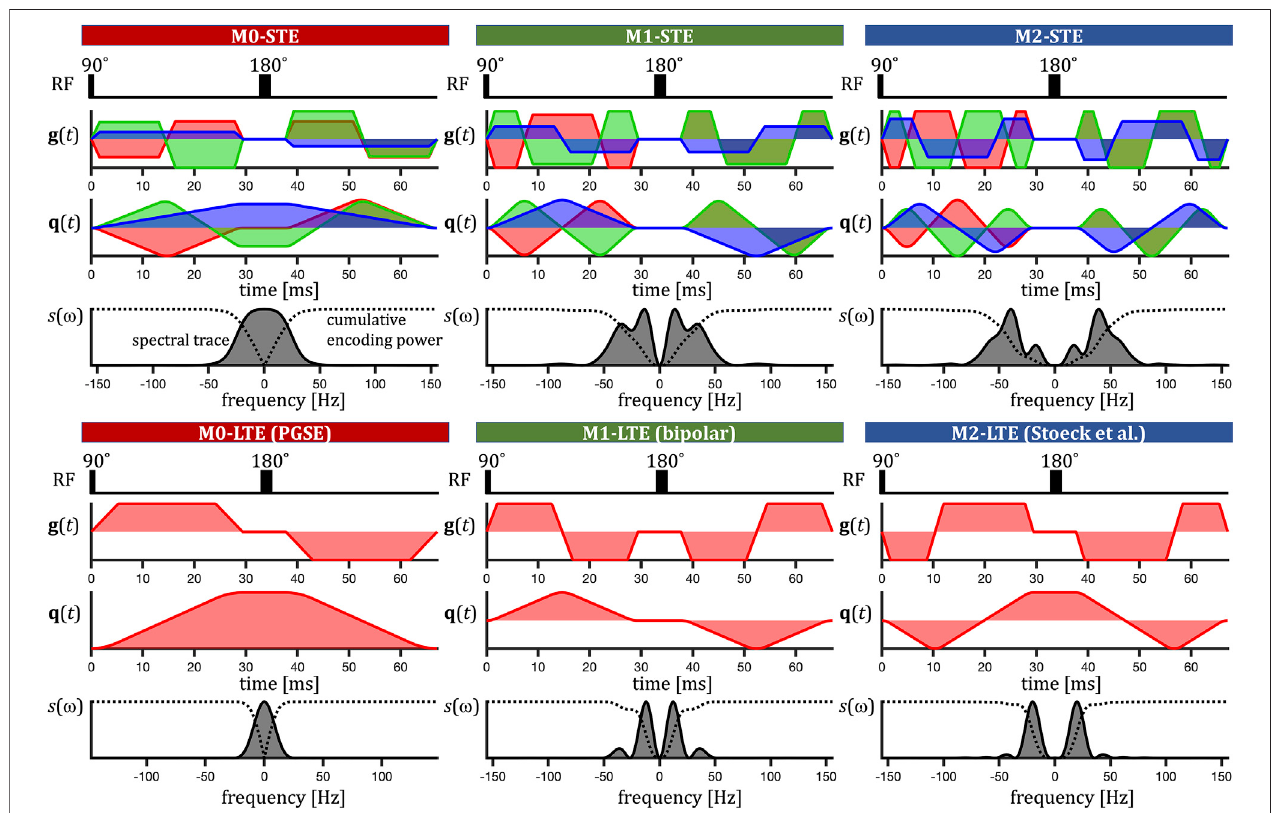
FIGURE 3 | Encoding on the clinical scanner. Radio frequency (RF) pulses, effective gradient waveforms g ( t ), dephasing waveforms q ( t ) (XYZ in red, green, blue) and normalized spectral trace s ( ω ) (greyshaded). Thenormalized cumulativeencoding power ~ b ( ω ) isshownasdotted line.Theexamples shown inthis fi gure areforthe longest encoding time of τ = 67 ms, which could accommodate all six encodings. In addition, experiments with M0- and M1-nulling were also applied at τ = 57 ms and experimentswithoutmotioncompensation(M0)werealsoappliedat τ =47 ms(see Table1 ).WhileSTEisverysimilartotheoneusedonapreclinicalscanner(see Figure 2 ), albeit with a shorter refocusing gap relative to the encoding duration, the LTEs were chosen to maximize b-value.